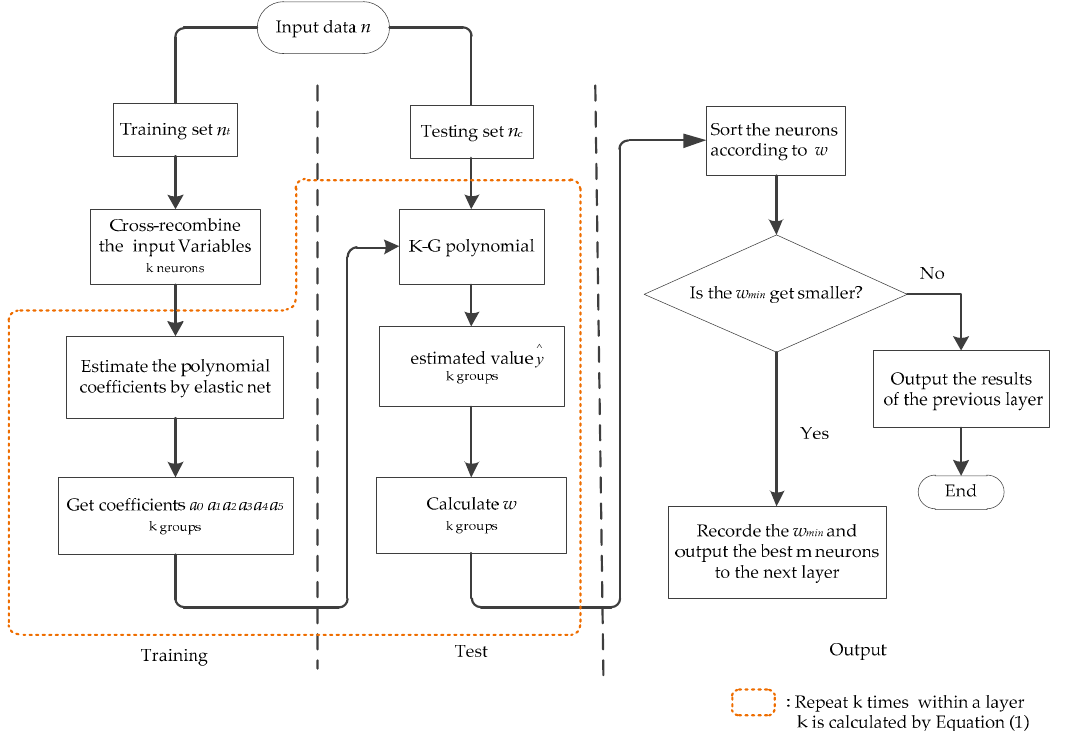
Figure 2. Group method of data handling based on elastic net (EN-GMDH) algorithm flow diagram.